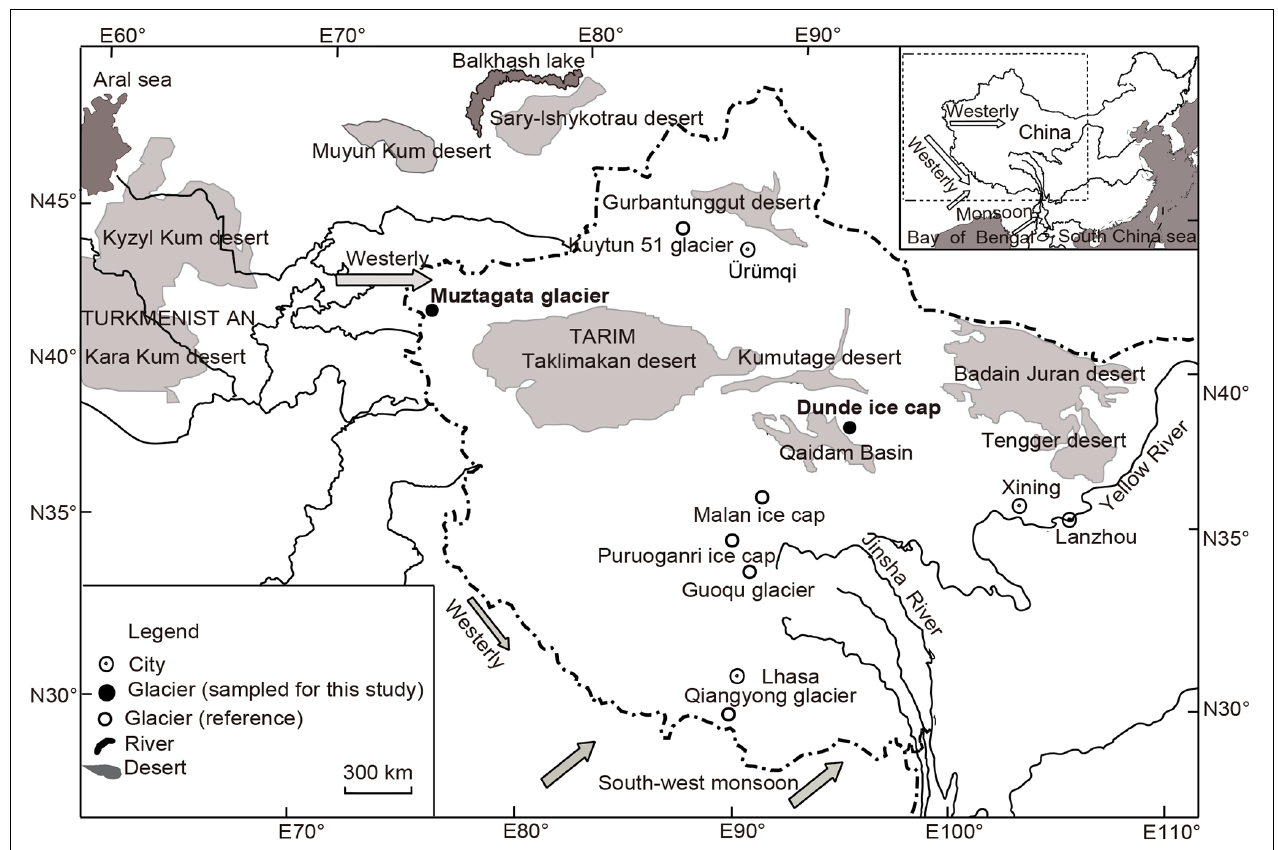
FIGURE 1 | Map illustrating the location of glaciers discussed in this study.